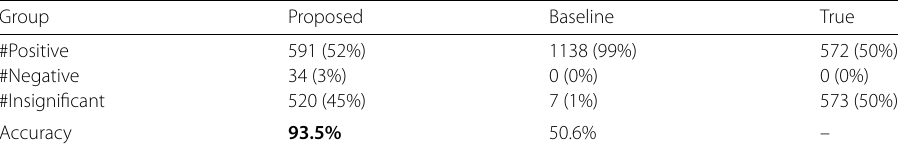
Table 2 Accuracy of detecting susceptible users when the topic trend is a confounding factor ( c = 1). “Proposed” and “Baseline” represent the introduced model with or without the topic trend g ( k , t ), respectively. Bold letters indicate that the accuracy is higher than 90% Group Proposed Baseline